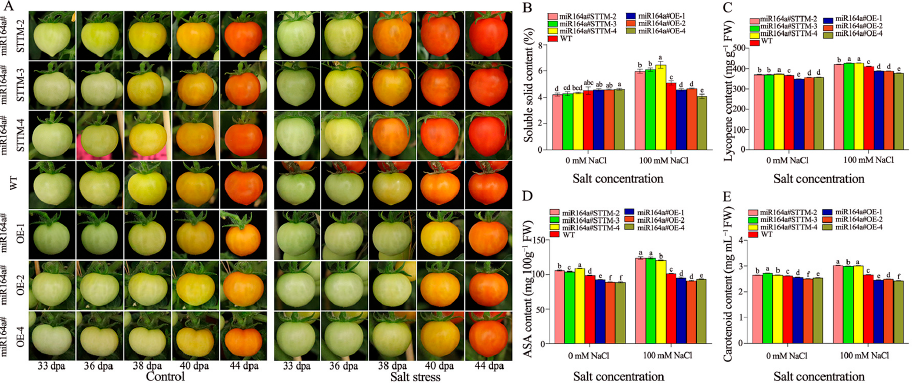
Figure 4. Changes of phenotypic characterization and nutritional quality of preharvest fruit in miR164a#STTM, WT and miR164a#OE tomato under control and salt stress. ( A ) Comparison of preharvest fruit development of miR164a#STTM, WT and miR164a#OE at 33–44 dpa under control and salt treatment. The contents of soluble solids ( B ), lycopene ( C ), ASA ( D ) and carotenoids ( E ) in miR164a#STTM, WT and miR164a#OE tomato fruit during salt treatment. Vertical bars represent standard deviations of the means, n = 3. Different letters indicated significant differences between WT and transgenic tomatoes in the values at p < 0.05.